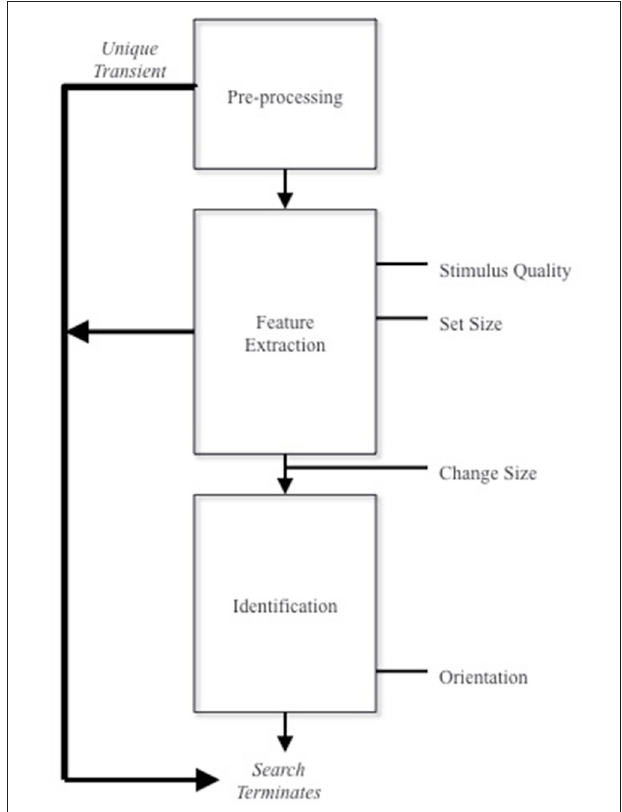
FIGURE 1 | Tovey and Herdman’s stage